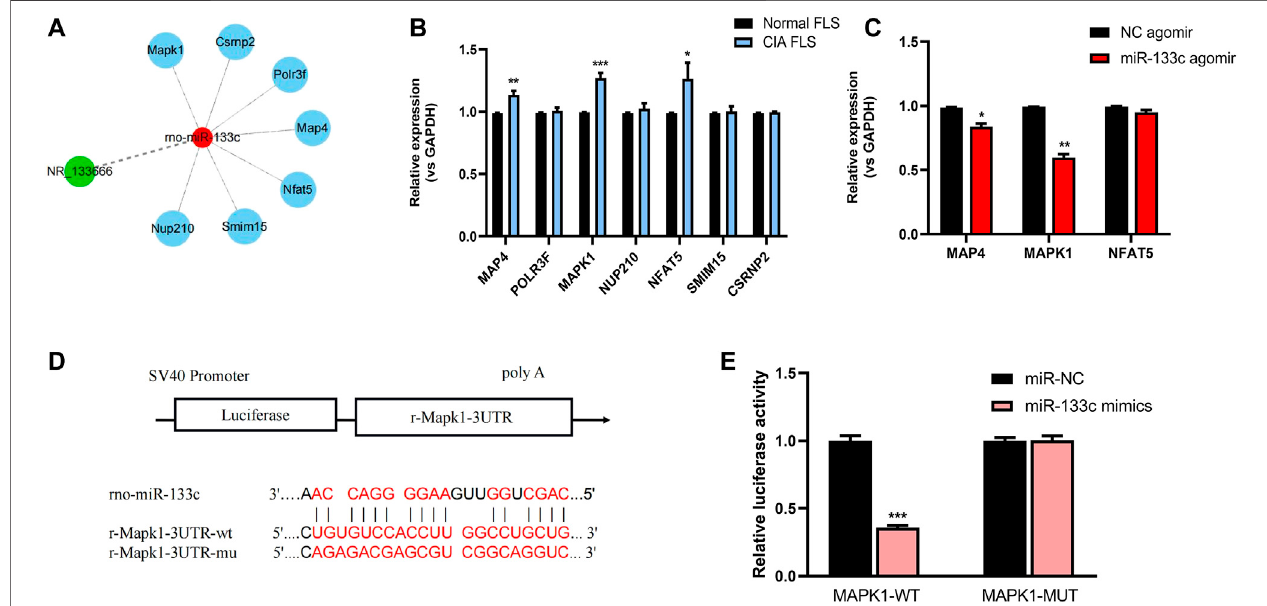
FIGURE 6 | MAPK1 was the target gene of miR-133c. (A) Targeted mRNAs of lncRNA NR-133666 – miR-133c axis scanned in databases of miRDB and TargetScan. (B) qRT-PCRshowedtheexpressionofmRNAinCIAFLS,comparedwithnormalFLS. (C) qRT-PCRshowedtheexpressionofMAP4,MAPK1andNFAT5 mRNAs in miR-133c agomir-transfected CIA FLS, compared with NC agomir. (D) Complementary bases of miR-133c and MAPK1. (E) Co-transfection of MAPK1 WT and miR-133c mimics decreased luciferase activity. Compared with controls, * p < 0.05, ** p < 0.01, *** p < 0.001.